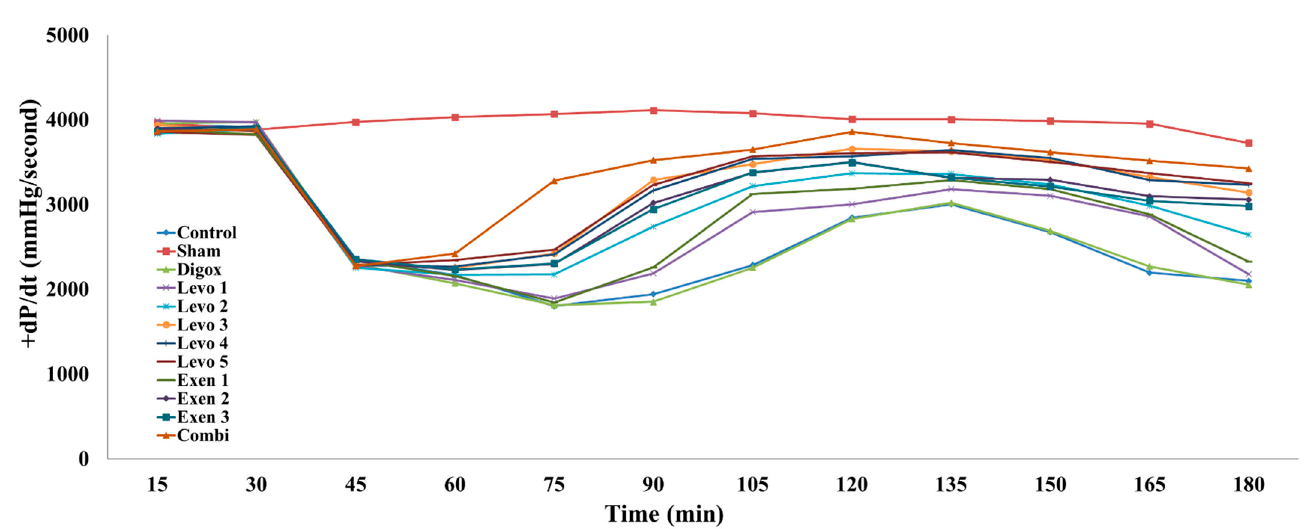
Figure 8. Changes in +dP/dt across groups over time.